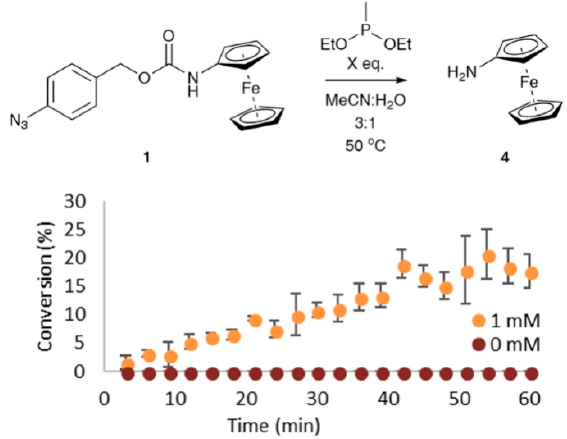
Figure 4. Conversion of probe 1 (10 mM) to aminoferrocene after the addition of diethylmethylphosphinite (X mM) in MeCN:H 2 O (3:1, 1 M) at 50 ◦ C. Error bars represent the standard deviation, where n =